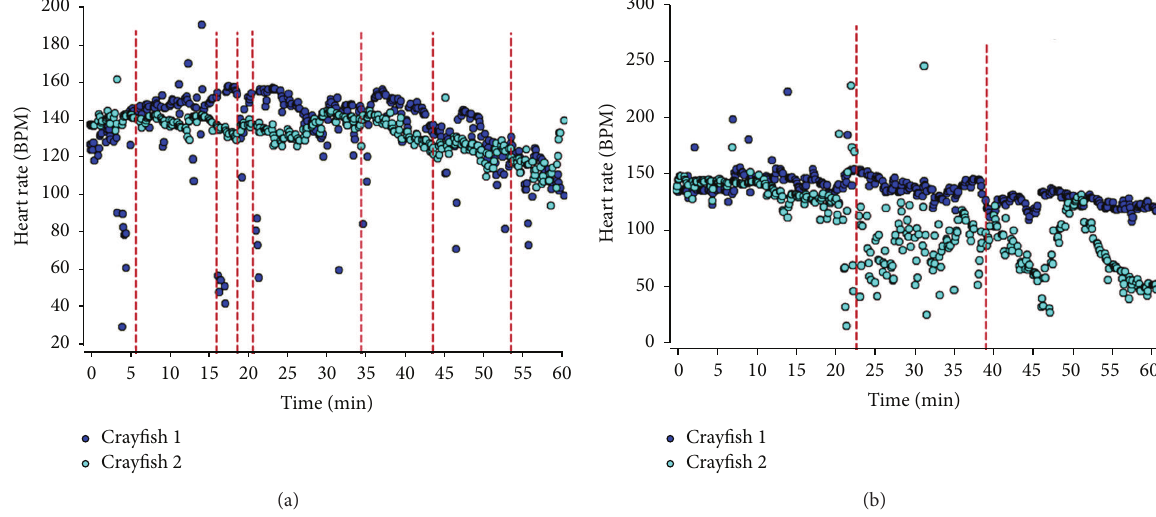
Figure 8: Physiological response of a single pair of crayfish. (a) “In water”. (b) “Out of water”. The dark blue line indicates crayfish one and light blue indicates crayfish two. Each point represents direct counts of each beat over 10-s intervals and then converted to beats per minute (BPM). The red dotted vertical lines indicate a physical interaction. The same pair was used in both conditions with multiple days in between each